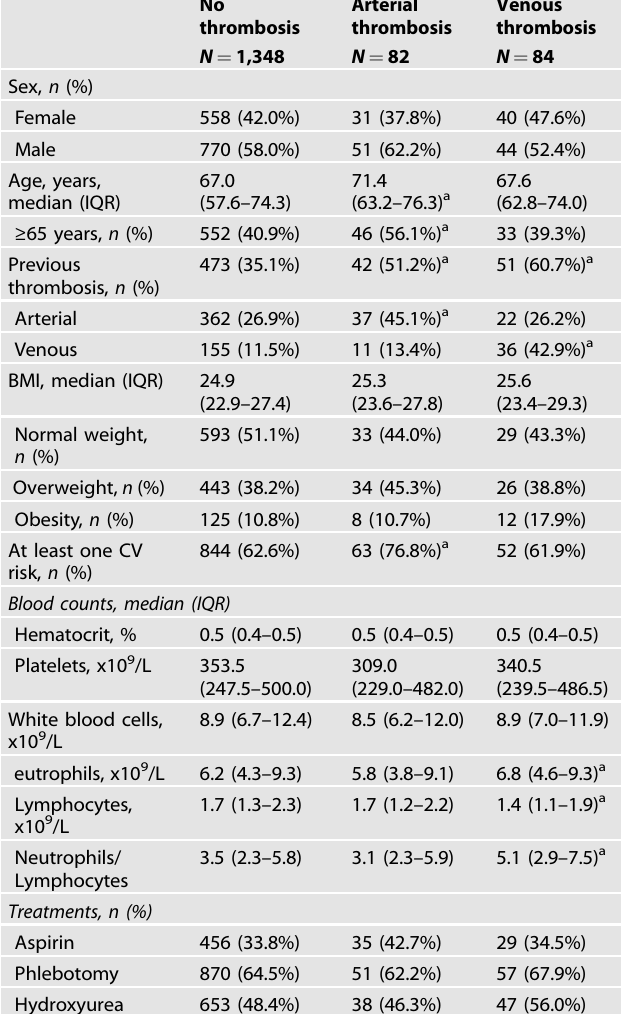
Table 2. Baseline characteristics according to occurrence and type of nonfatal thrombosis during